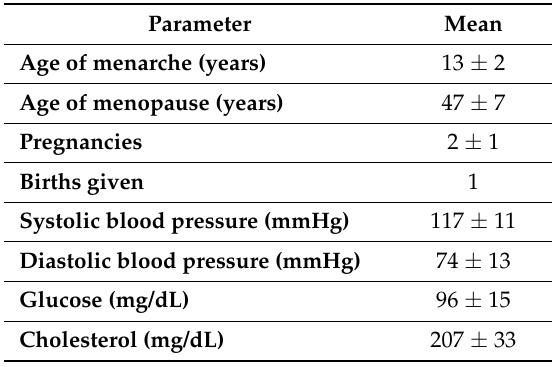
Table 1. Demographic variables of the current population.